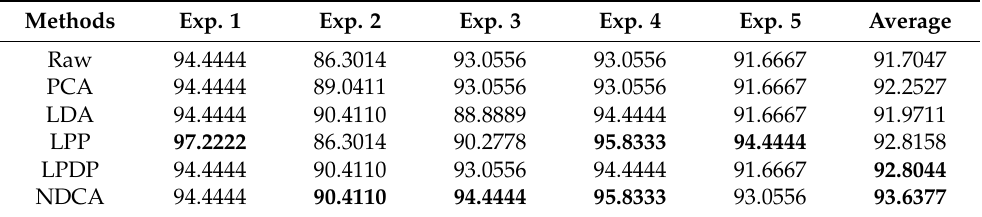
Table 7. Classification accuracy (%) of different dimension reduction algorithms using SVM as the